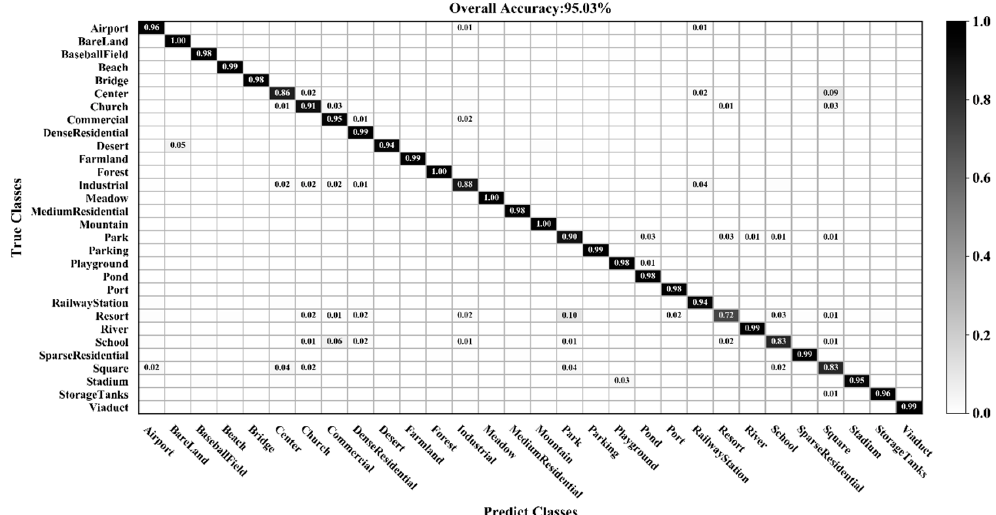
Figure 14. Confusion matrix using a training ratio of 20% on the AID dataset.